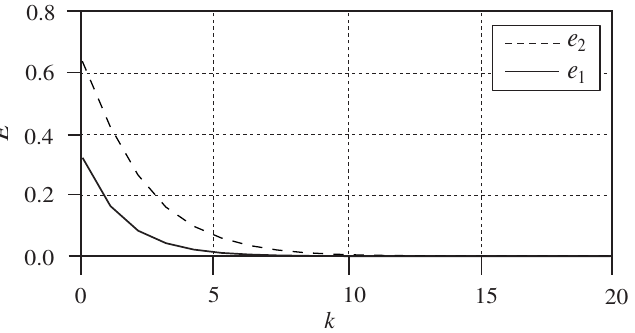
Figure 7. The iterative number-max tracking